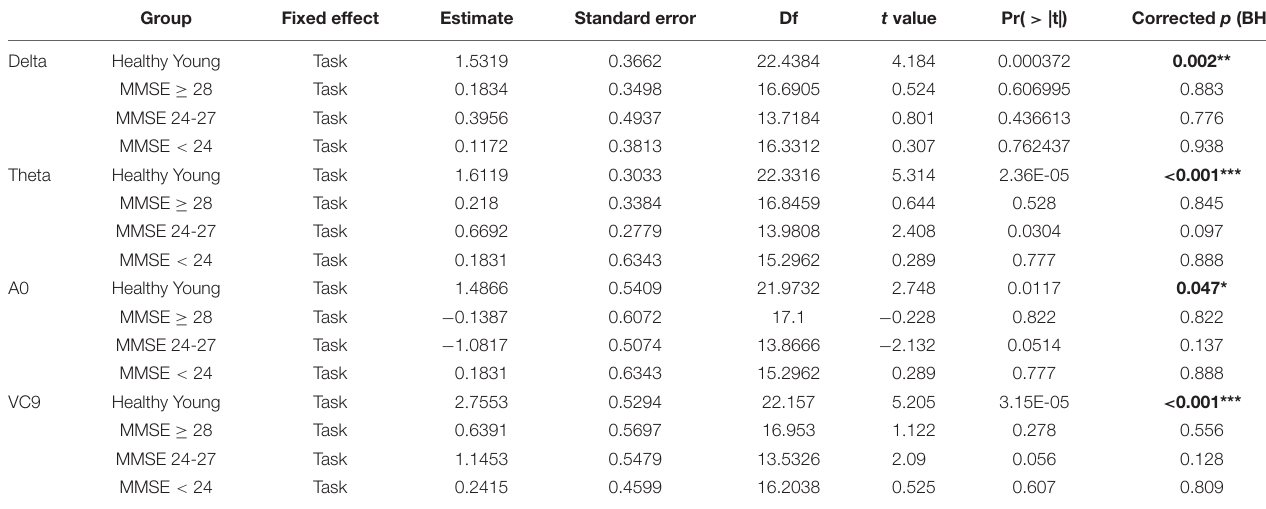
TABLE 7 | Estimate, Standard errors, df, t -values and p- values, and BH-corrected p -values of the separate GLMM conducted on each group, with task level as a within-participants variable. Group